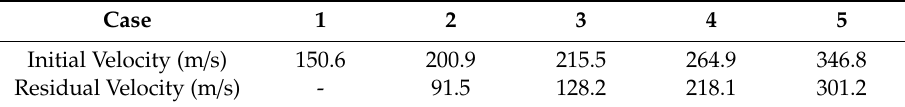
Table 3. Initial and residual velocities of projectiles ( t pl = 10 mm).